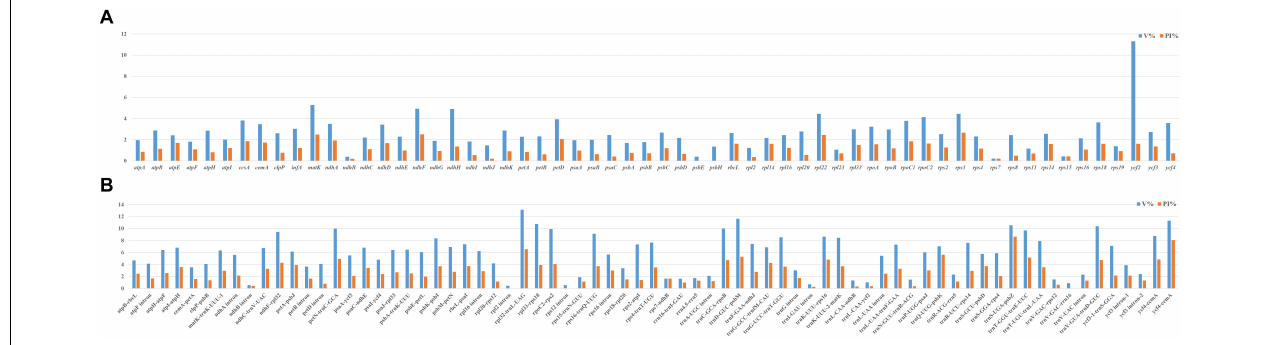
FIGURE 4 | Comparison of percentage of parsim-info sites among 32 plastomes. (A) PCGs, X -axis: name of PCGs, Y -axis: percentage of variable sites; (B) NCRs, X -axis: name of NCRs, Y -axis: percentage of parsim-info